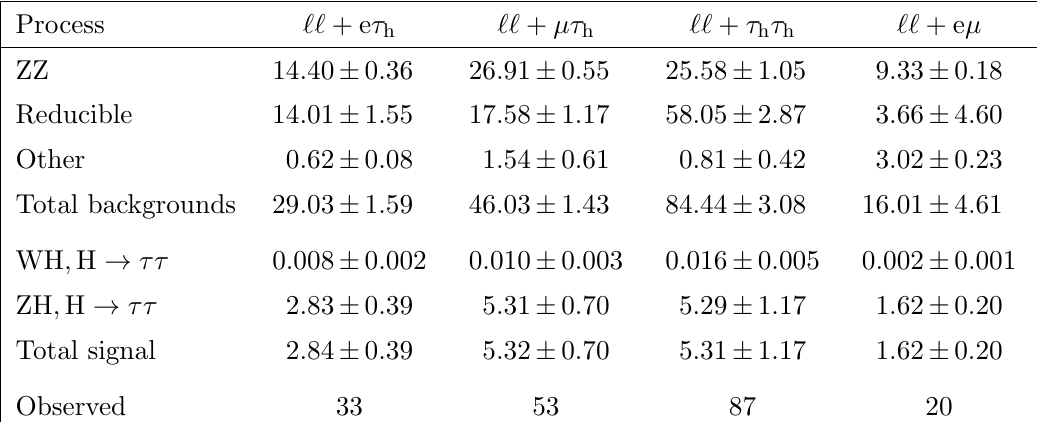
Table 3 . Background and signal expectations for the ZH channels, together with the numbers of observed events, for the post-(cid:12)t signal region distributions. The ZH (cid:12)nal states are each grouped according to the Higgs boson decay products. The ‘‘ notation covers both Z ! (cid:22)(cid:22) and Z ! ee events. The WH and ZH, H ! (cid:28)(cid:28) signal yields are listed both individually and summed together, and correspond to H ! (cid:28)(cid:28) with a best (cid:12)t (cid:22) = 2 : 5 for a Higgs boson with a mass m H = 125 GeV. The background uncertainty accounts for all sources of background uncertainty, systematic as well as statistical, after the global (cid:12)t. The contribution from \Other" includes events from triboson, tt + W/Z, ttH production, and all production modes leading to H ! WW and H ! ZZ decays.